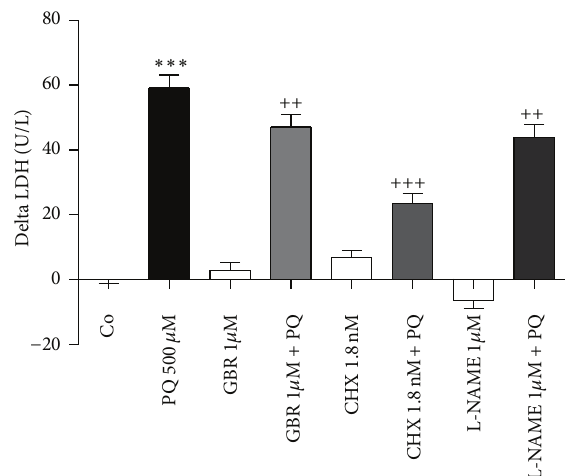
Figure 4: TIR and NaSAL decreased PQ-induced LDH release into the medium, while NAC afforded no protection. Differentiated SH- SY5Y cells were pretreated with TIR (100 𝜇 M and 1mM), NaSAL (100 𝜇 M, 1mM), and NAC (1mM) 30 minutes prior to cultures exposure to PQ for 72h. The delta increase in LDH release in units per liter (U/L) into the medium was calculated by subtraction of the respective controls (results were pooled from 3 different experiments, each experiment having 6 different culture wells per condition). The means were compared using one-way ANOVA, followed by Student-Newman-Keuls post hoc test ( ∗∗∗ 𝑃 < 0.001 PQ versuscontrol; +++ 𝑃 < 0.001 PQversusPQplusprotector; $ 𝑃 < 0.05 , $$ 𝑃 < 0.01 PQ plus protector low concentration versus PQ plus protector high concentration).